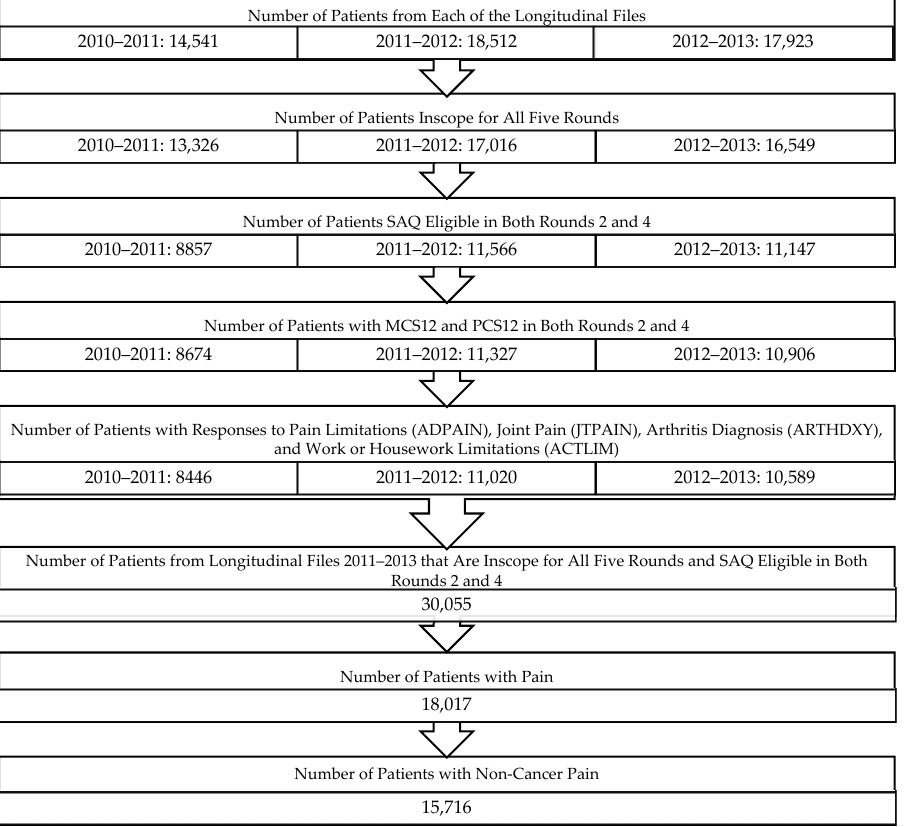
Number of Patients with Non-Cancer Pain